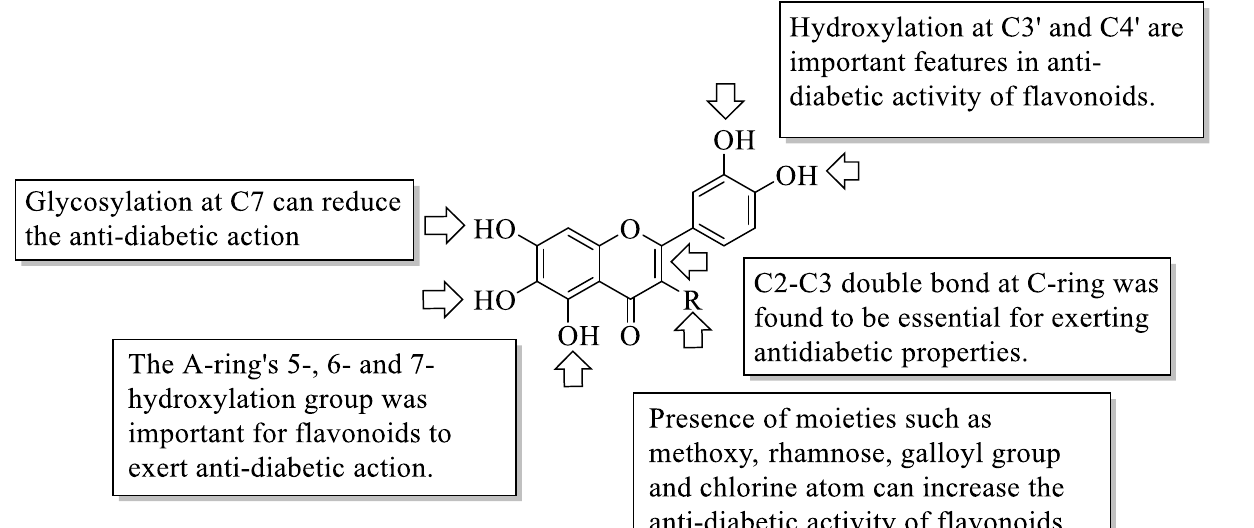
Figure 30. The SAR of flavonoids as an antidiabetic agent.